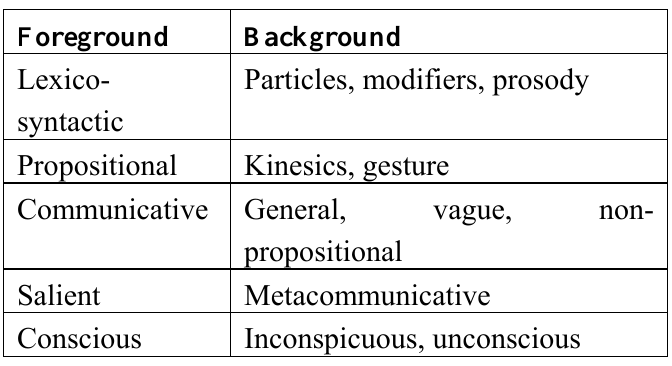
Table 1. Conversation’s division of